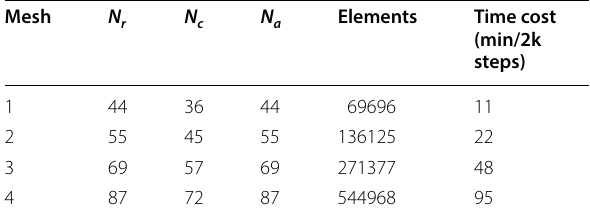
Table 1 Mesh parameters and iteration times